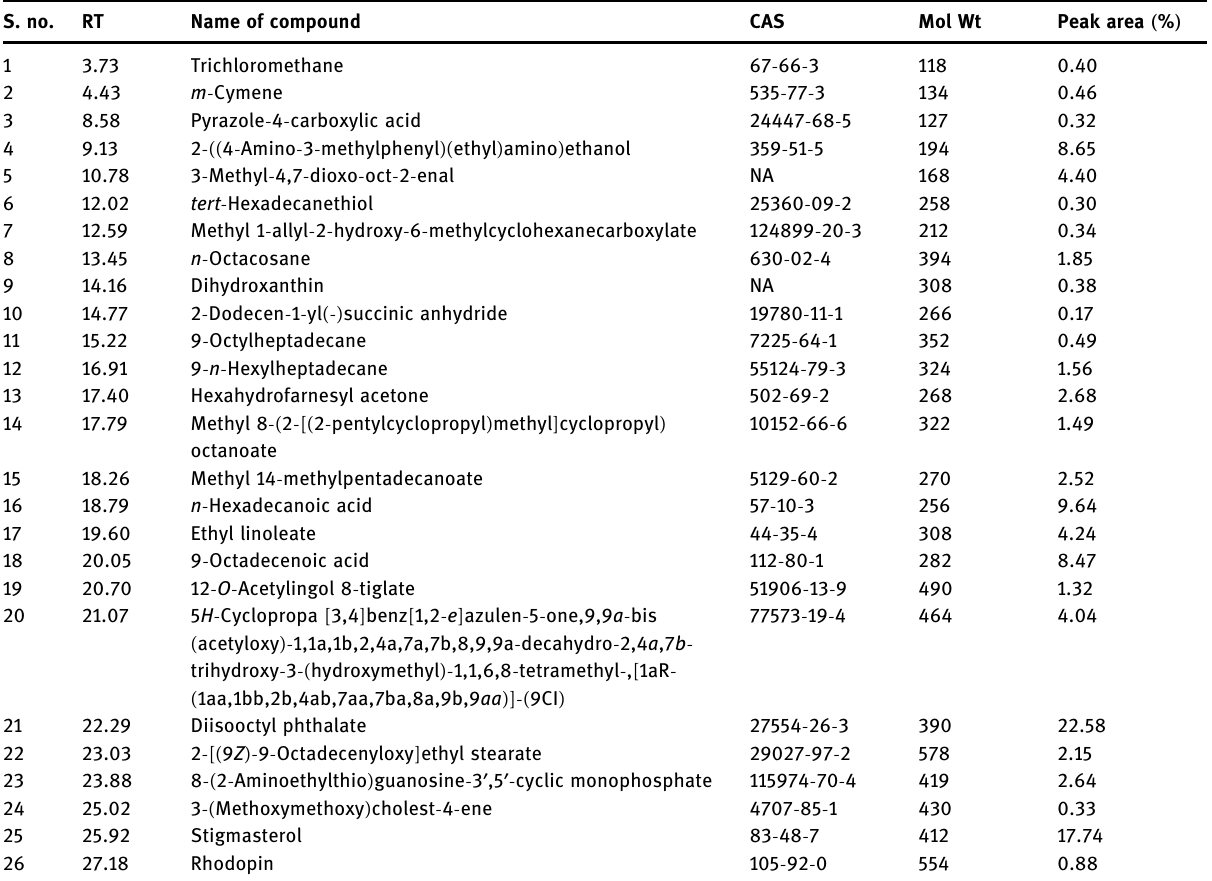
Table 4: List of compounds in the chloroform fraction of C. murale S. no.